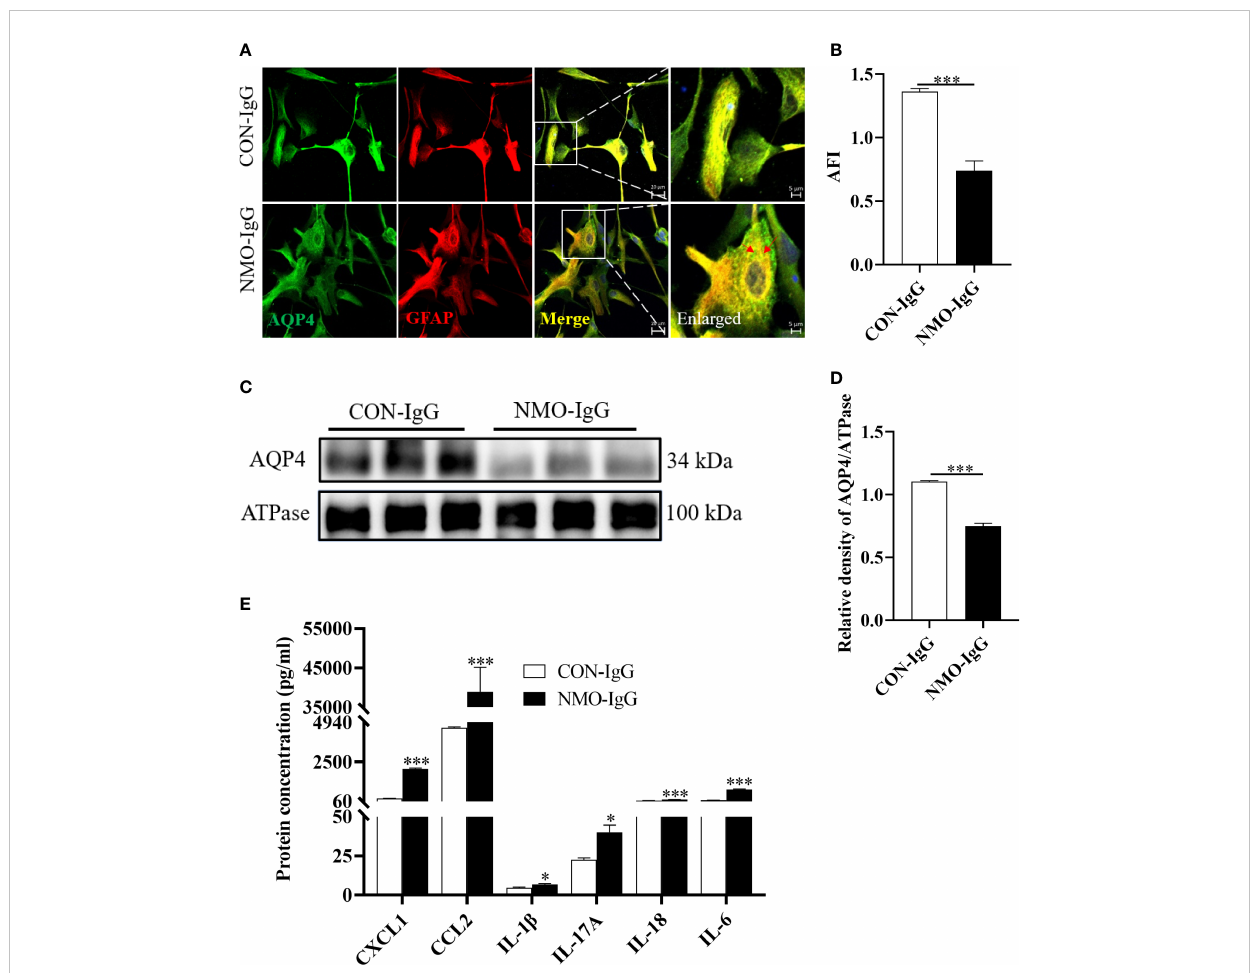
FIGURE 3 Damage effects of NMO-IgG on astrocytes in vitro . Rat primary astrocytes were exposed to either NMO-IgG (4 U) puri fi ed from a serum pool of more than 10 AQP4-IgG-seropositive NMOSD patients or human commercial control IgG (CON-IgG) for 4 hours. (A) The AQP4 protein (green) was uniformly distributed on the cytomembrane of the astrocytes after CON-IgG incubation, whereas, after NMO-IgG incubation, there were obvious AQP4 protein aggregations on the cytomembrane and some of these were internalized into the cytoplasm and degraded into granules. The scale bars in merged and enlarged pictures are 20 and 5 m m, respectively. (B) Compared with the CON-IgG group, the average fl uorescence intensity (AFI) of AQP4 in the NMO-IgG group signi fi cantly decreased. (C) Cytomembrane lysates from astrocytes were immunoblotted with antibodies against AQP4, and NMO-IgG induced a signi fi cant decrease in AQP4 expression on cell membranes compared with the CON-IgG group. (D) The ratio of AQP4 density to its internal reference, ATPase, is shown. (E) NMO-IgG caused the release of several chemokines or cytokines, with CCL2 being the most pronounced. Data are presented as the mean ± SE of three or fi ve independent experiments. *** p < 0.001. The red arrows indicate areas of AQP4 protein aggregation, symbol "*" indicates p <